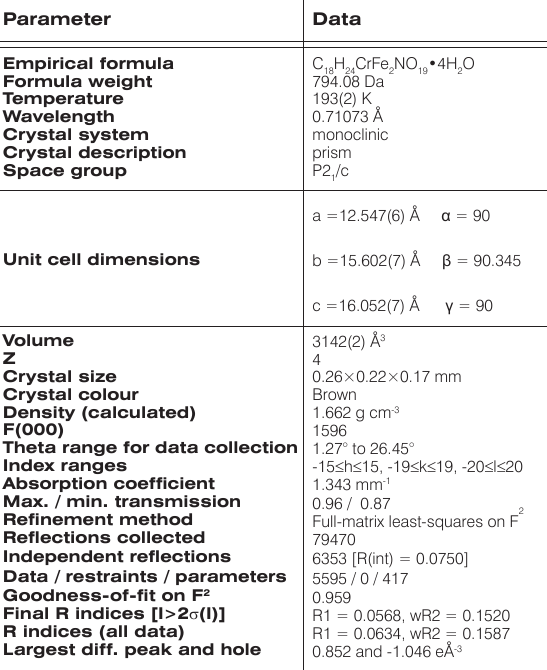
Packing diagram (unit cell) viewed along the a-axis (b). The thermal ellipsoids are drawn at the 50% probability level.